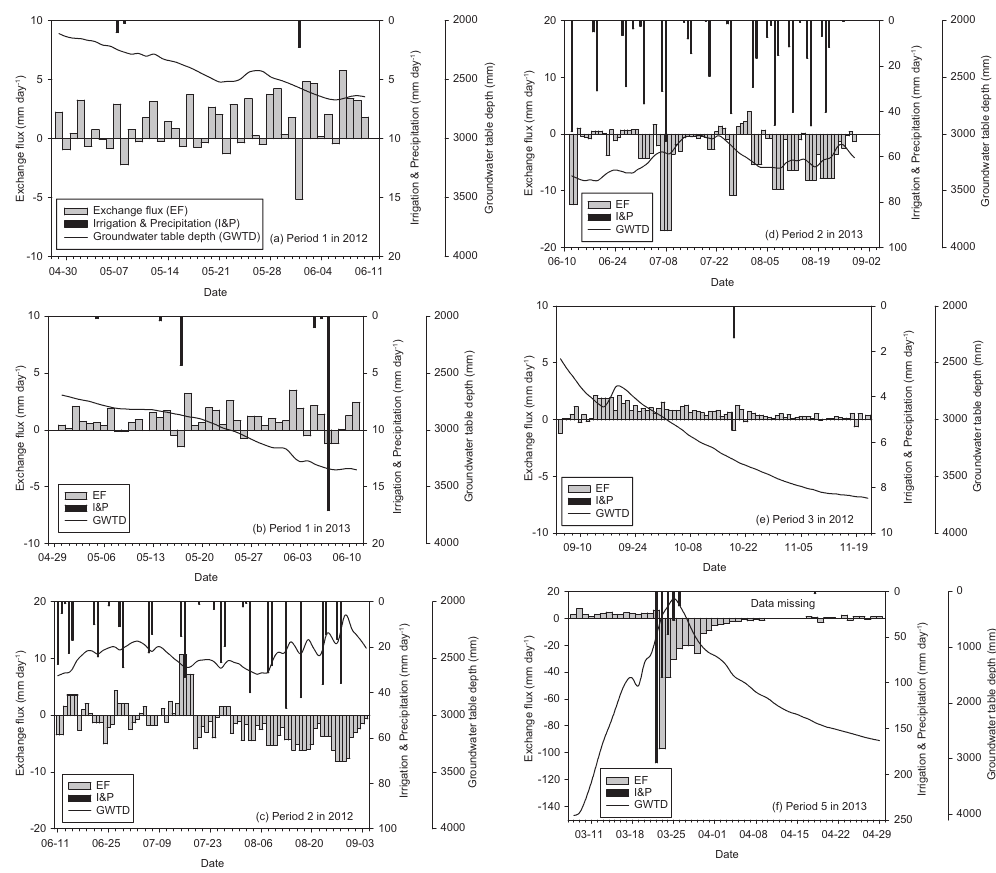
Figure 7. Exchange flux at 900mm soil depth and groundwater table variation. Positive EFs represent upward fluxes and negative EFs represent downward